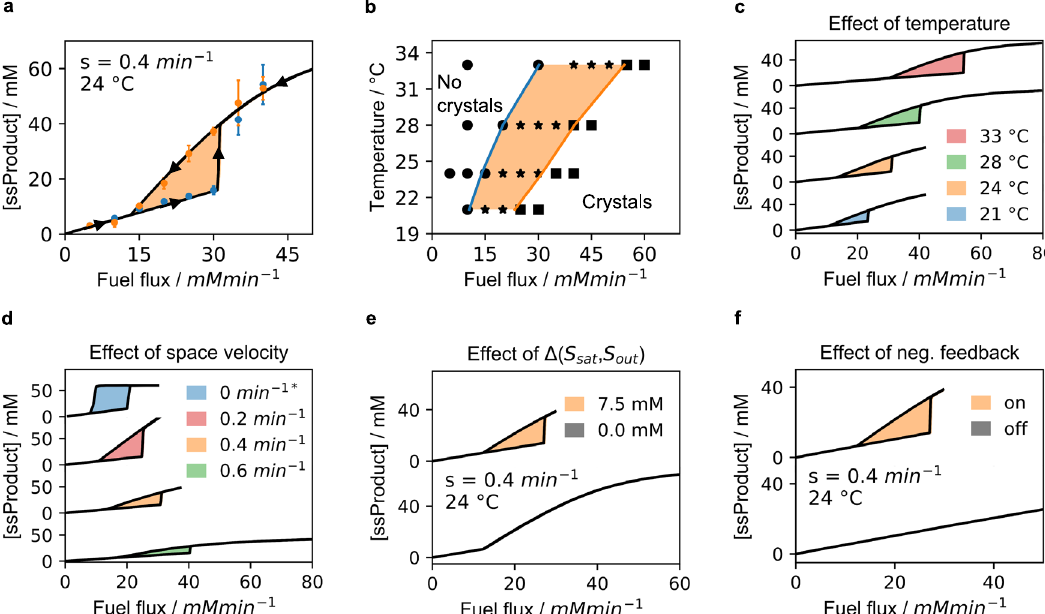
Fig. 3 The bistable window can be tuned by a range of parameters. a The steady state concentration determined by the kinetic model (line) and HPLC (markers) at different fuel fl uxes yields a hysteresis curve. The precursor in fl ux was kept at 30 mM.min − 1 and the space velocity was 0.4 min − 1 . The markers represent the measured mean steady state concentration and their standard deviation ( n = 5). b The bistability window at various temperatures as determined by turbidity measurements. The conditions are the same as for a except for the temperature. The stars mark the energy fl ux at which two stable steady states were found. c The effect of temperature on the hysteresis curve as determined by the kinetic model. The conditions are the same as for b. The intersection of the high- and low energy branch is drawn in b as blue and orange line. d The effect of the space velocity on the bistability window as calculated by the kinetic model at 24 °C. The conditions are the same as for a. (*) For a space velocity of 0.0 min − 1 , 60 mM precursor starting concentration was used. e The in fl uence of the metastable zone and ( f ), negative feedback on the bistability